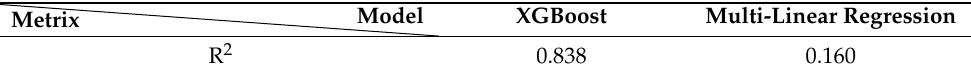
Table 5. Comparison of the pseudo-R 2 between the XGBoost model and multi-linear